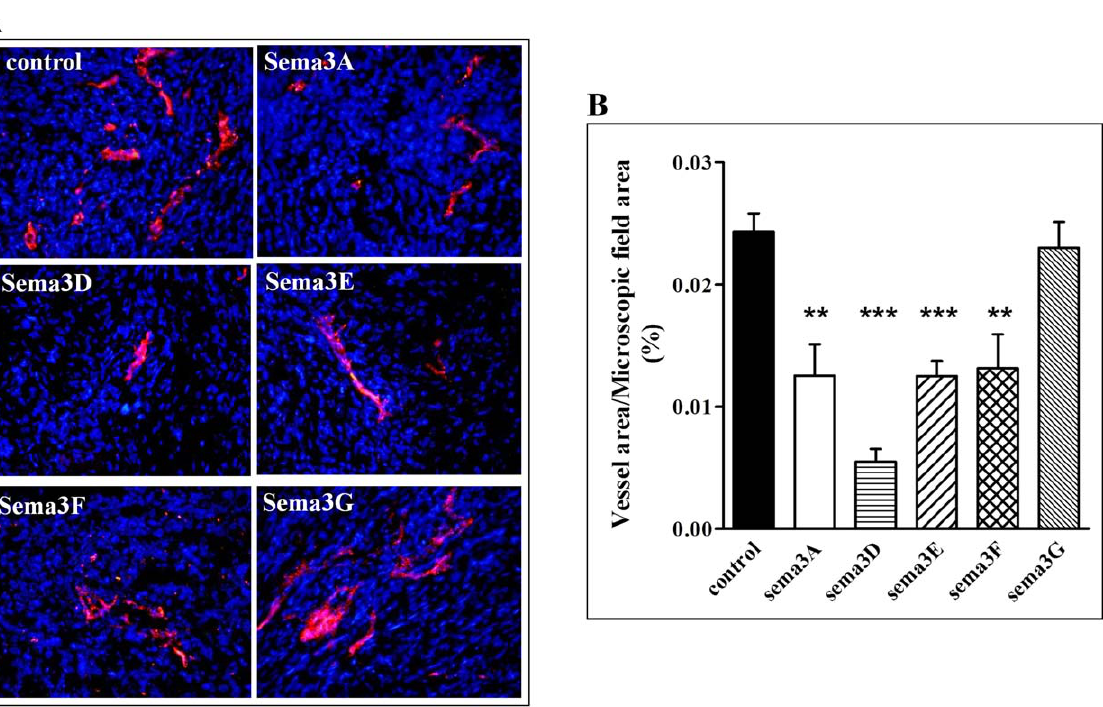
Figure 3. The effect of the expression of class-3 semaphorins on the microvascular density of subcutaneous tumors derived from U87MG glioblastoma cells: Tumors excised from mice injected subcutaneously with U87MG cells infected with empty control lentiviruses (control), or lentiviruses directing expression of the designated class-3 semaphorin were embedded in OCT and frozen as described in materials and methods. Frozen sections (20 m m) were stained with anti CD-31 antibody (red) and nuclei were stained with DAPI (blue), as described in materials and methods. ( A ) Representative pictures (20 6 ) of microscopic fields taken from tumor areas in which the density of blood vessels was highest. Pictures were taken using a fluorescent microscope. ( B ) The area of CD-31 stained blood vessels in fields of equal area was quantified as described in materials and methods.